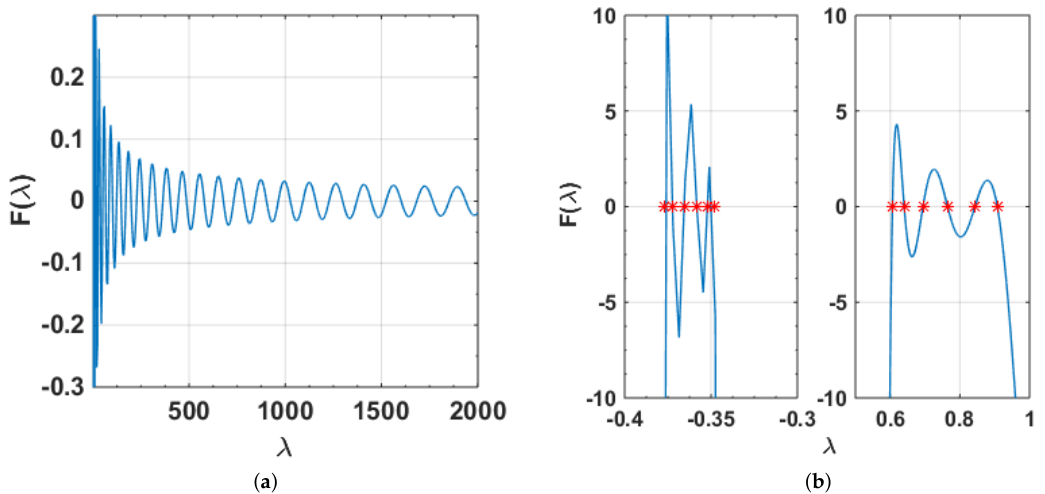
Figure 3. ( a ) Characteristic function of − y (cid:48)(cid:48) + ( x + 0.1 ) − 2 y = λ y , 0 < x < π , y ( 0 ) = y ( π ) = 0. ( b ) Parts of the characteristic equation (blue) and first 12 eigenvalues (red) for the version of Mathieu Equation